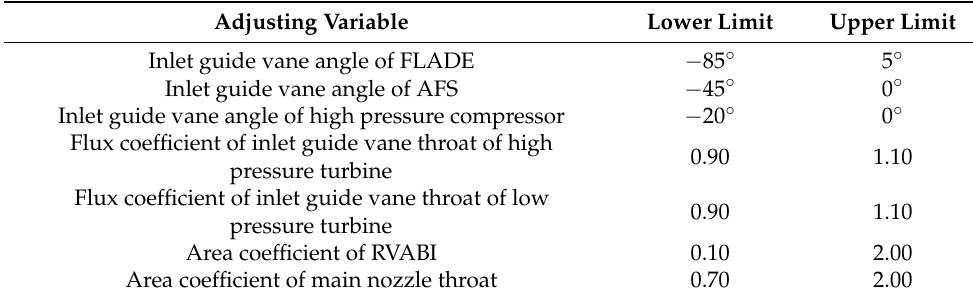
Table 2. Adjustment Ranges of Main Adjusting